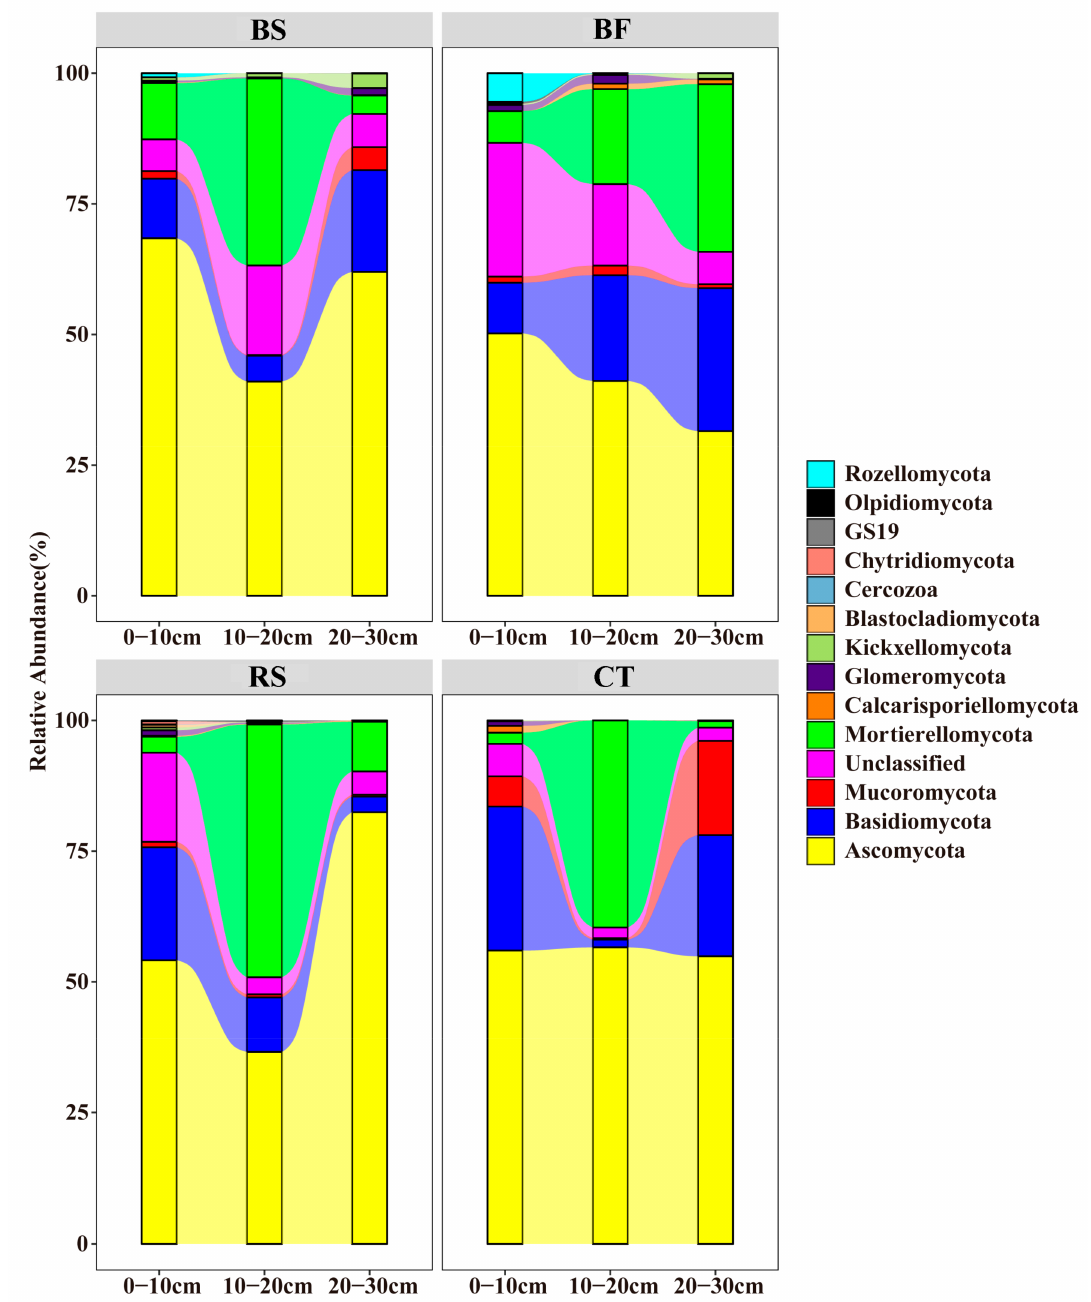
Figure 5. Phylum-level taxonomic composition of the fungal community under different soil and water conservation measures. Note: the parts with an average abundance of less than 1% were merged and indicated by others in the